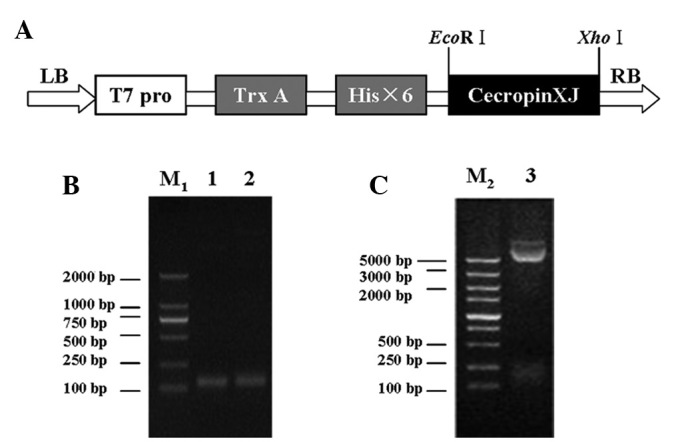
Identification of the recombinant plasmid. (A) Schematic structure of pET32a-cecropinXJ. T7 Pro, T7 promoter; LB and RB, left and right border of the expression vector pET32a. (B) Identification of recombinant plasmid by plasmid polymerase chain reaction (PCR). Lane M1, DNA molecular weight standards; lane 1, PCR product of the cecropinXJ gene fragment with the recombinant plasmid pMD18-T-cecropinXJ as template; lane 2, PCR product of the cecropinXJ gene fragment with the recombinant plasmid pET32a-cecropinXJ as template. (C) Identification of recombinant plasmid pET30a-cecropinXJ by digestion with EcoRI and XhoI. Lane M2, DNA molecular weight standards; lane 3, DNA fragment of pET32a-cecropinXJ digested with EcoRI and XhoI. PCR,.